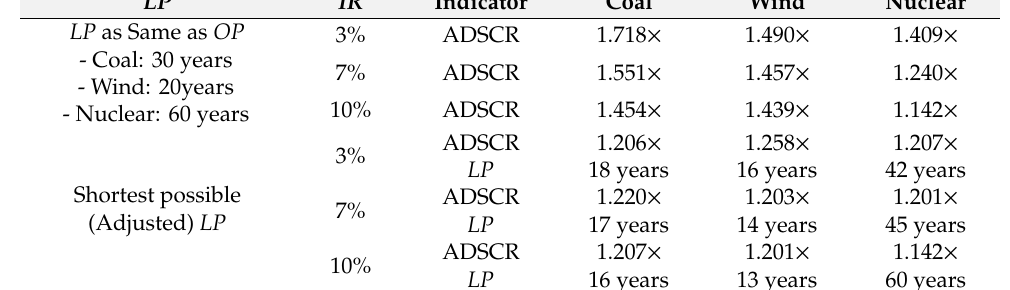
Table 6. ADSCR values of Coal, Wind, and Nuclear during original and adjusted LPs.